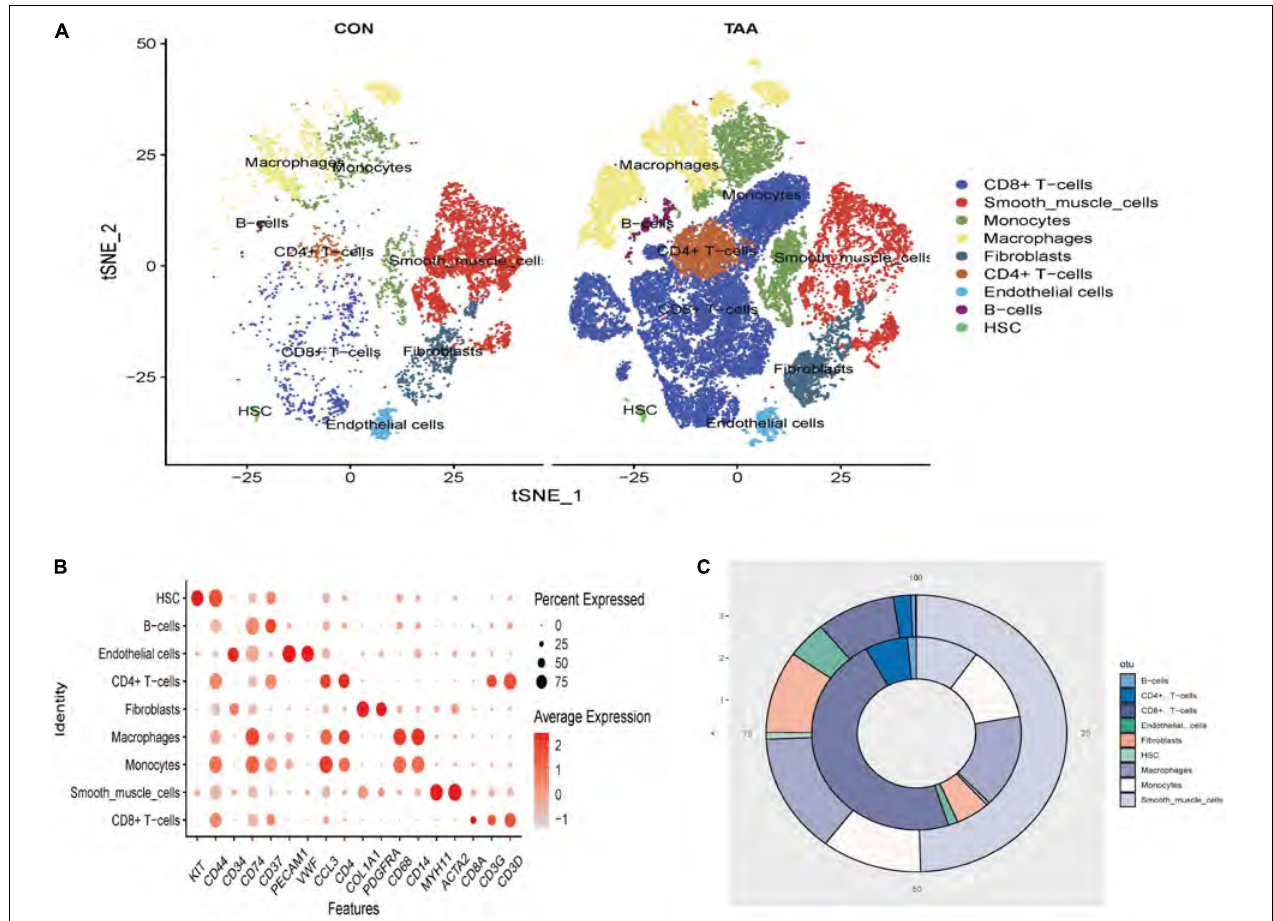
FIGURE 1 | Clustering all cells filtrated from GSE155468. The t-distributed stochastic neighbor embedding (t-SNE) plot of the aligned gene expression of cells from the normal aorta and aortic aneurysms, respectively, showing the distribution of nine cell identities (A) . The expression level and expression percentage of marker genes are illustrated on the dot plot (B) . The change of proportion of identified cell types was shown in a donut chart (C) . The proportion of adipocyte-like VSMCs, mesenchymal-like VSMCs, macrophage-like VSMCs, and T-cell-like VSMCs significantly increased in aortic aneurysms (inner donut), and the proportion of contractile VSMCs dramatically decreased in the normal aorta (outer